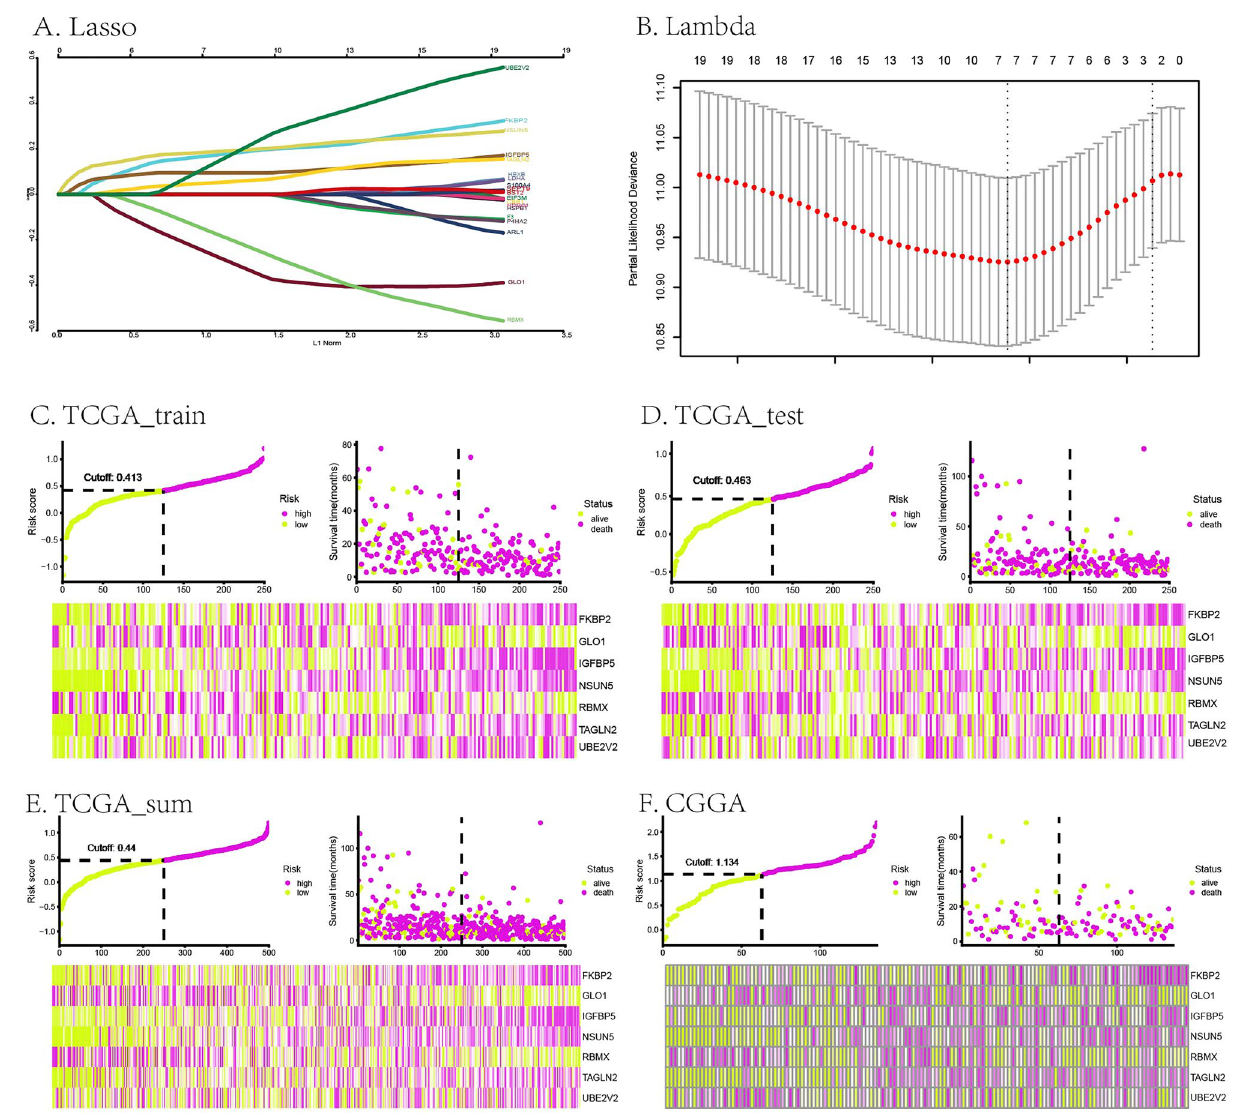
Figure 2. Construction of the prognostic risk score model based on a hypoxic 7-gene signature in GBM. ( A , B ) Lasso and Lambda of the risk score model. ( C – F ) risk score curves, dot diagrams and heat maps of the risk score model in TCGA (train set, test set, sum set) and